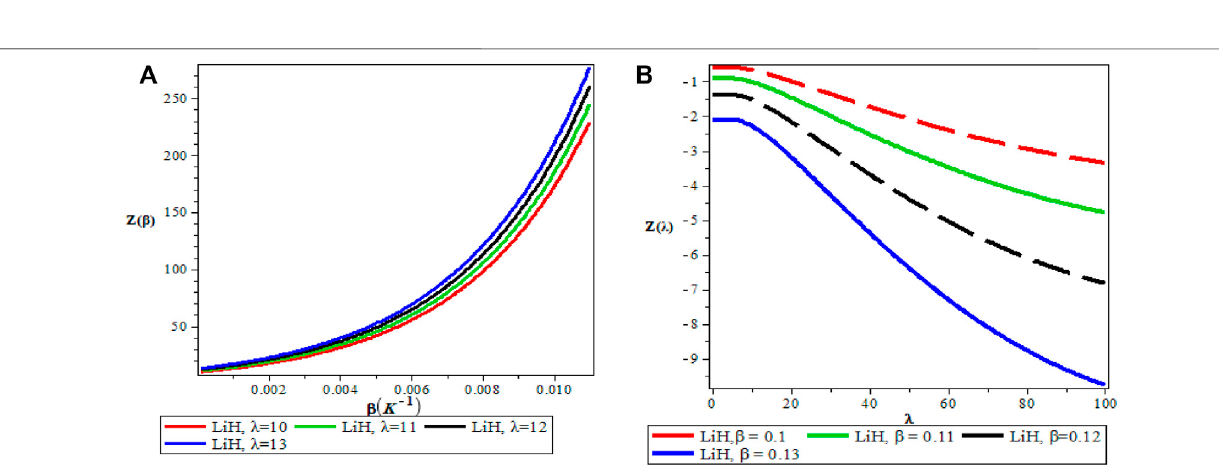
Frontiers in Physics |